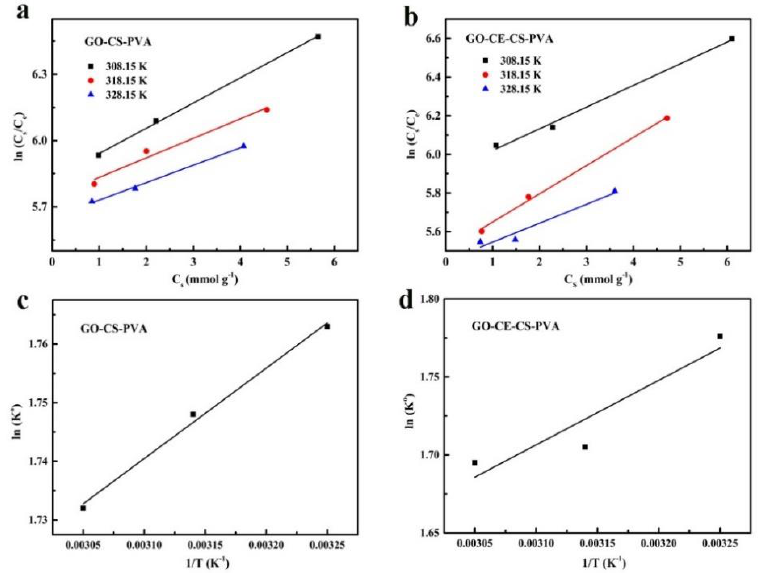
Figure 9. Plots of ln (Cs/Ce) as a function of Cs at different temperatures (308.15 K, 318.15 K, and 328.15 K): ( a ) GO–CS–PVA and ( b ) GO–CE–CS–PVA. ∆ H 0 and ∆ S 0 were obtained by linear fitting plots ln K 0 against 1/T: ( c ) GO–CS–PVA and ( d ) GO–CE–CS–PVA. Table 3. The adsorption thermodynamic parameters of GO − CE − CS − PVA and GO − CS − PVA for Li + .